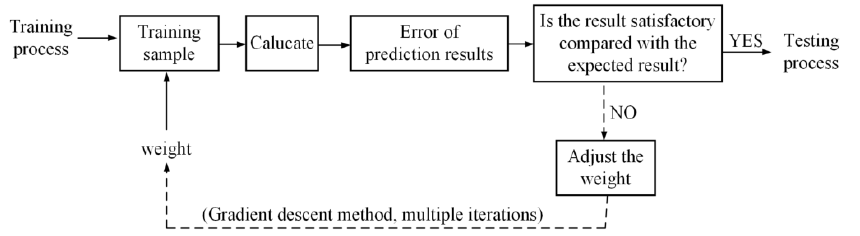
Figure 8. Weight updating process.